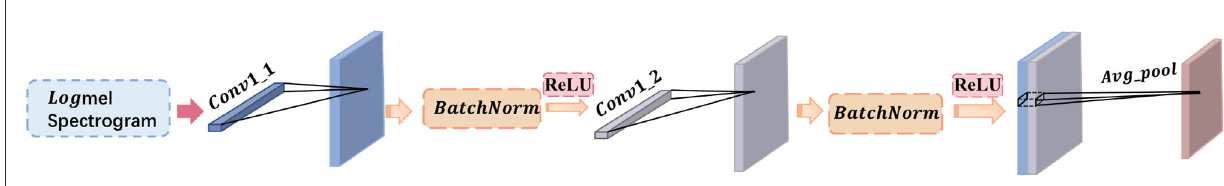
FIGURE1 Schematic diagram of the convolutional block model.